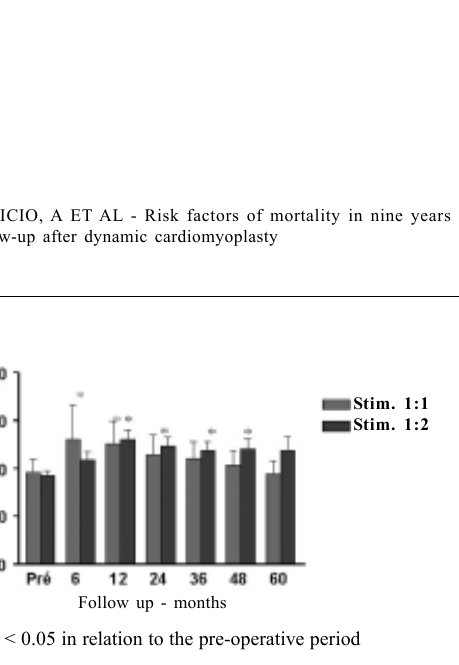
Fig. 6 - Analysis of the ejection fraction using radioisotopic angiography in the pre-operative period until five years of follow up.